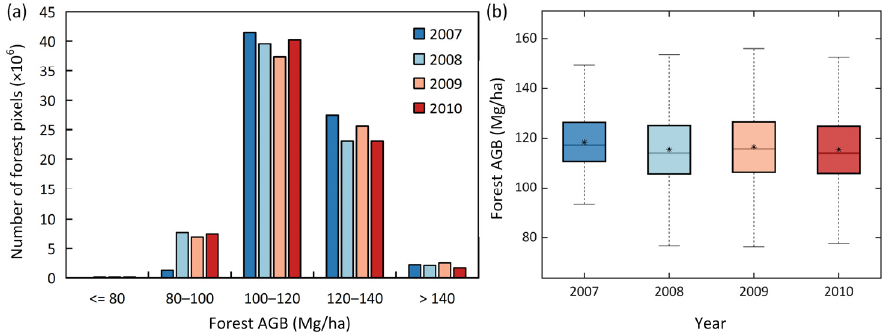
Figure 11. Distributions of AGB predictions for 2007–2010: ( a ) shows the number of forest pixels that had AGB values within each bin; and ( b ) shows AGB for each year, and * indicates the mean AGB for each year.